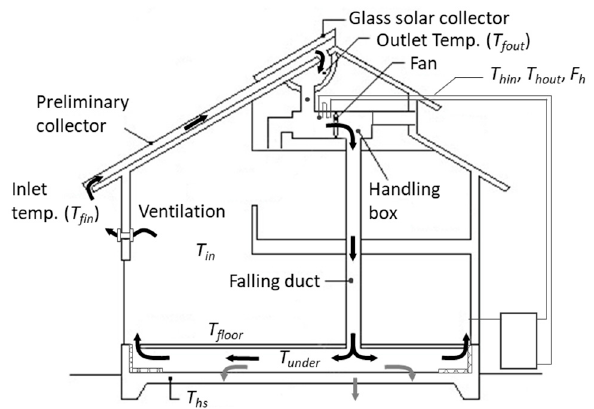
Figure 15. Conceptual diagram of the heat balance calculation.